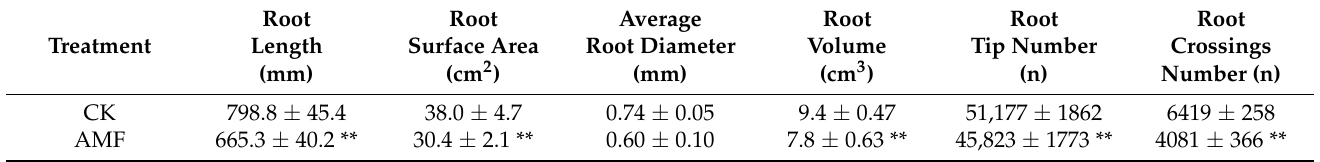
Table 1. Effects of AMF on root morphology of maize under 20 mg · L − 1 Cd concentration stress.